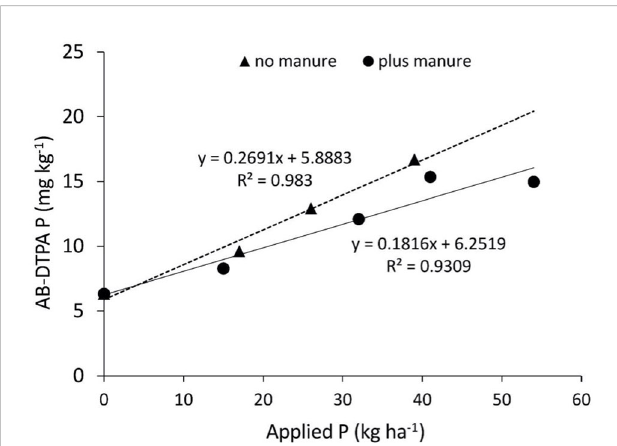
FIGURE 1 Correlations between plant-available P (extracted with ammonium bicarbonate-diethylenetriamine pentaacetate (AB-DTPA)) and applied P for soil incubated under laboratory conditions. The applied P was